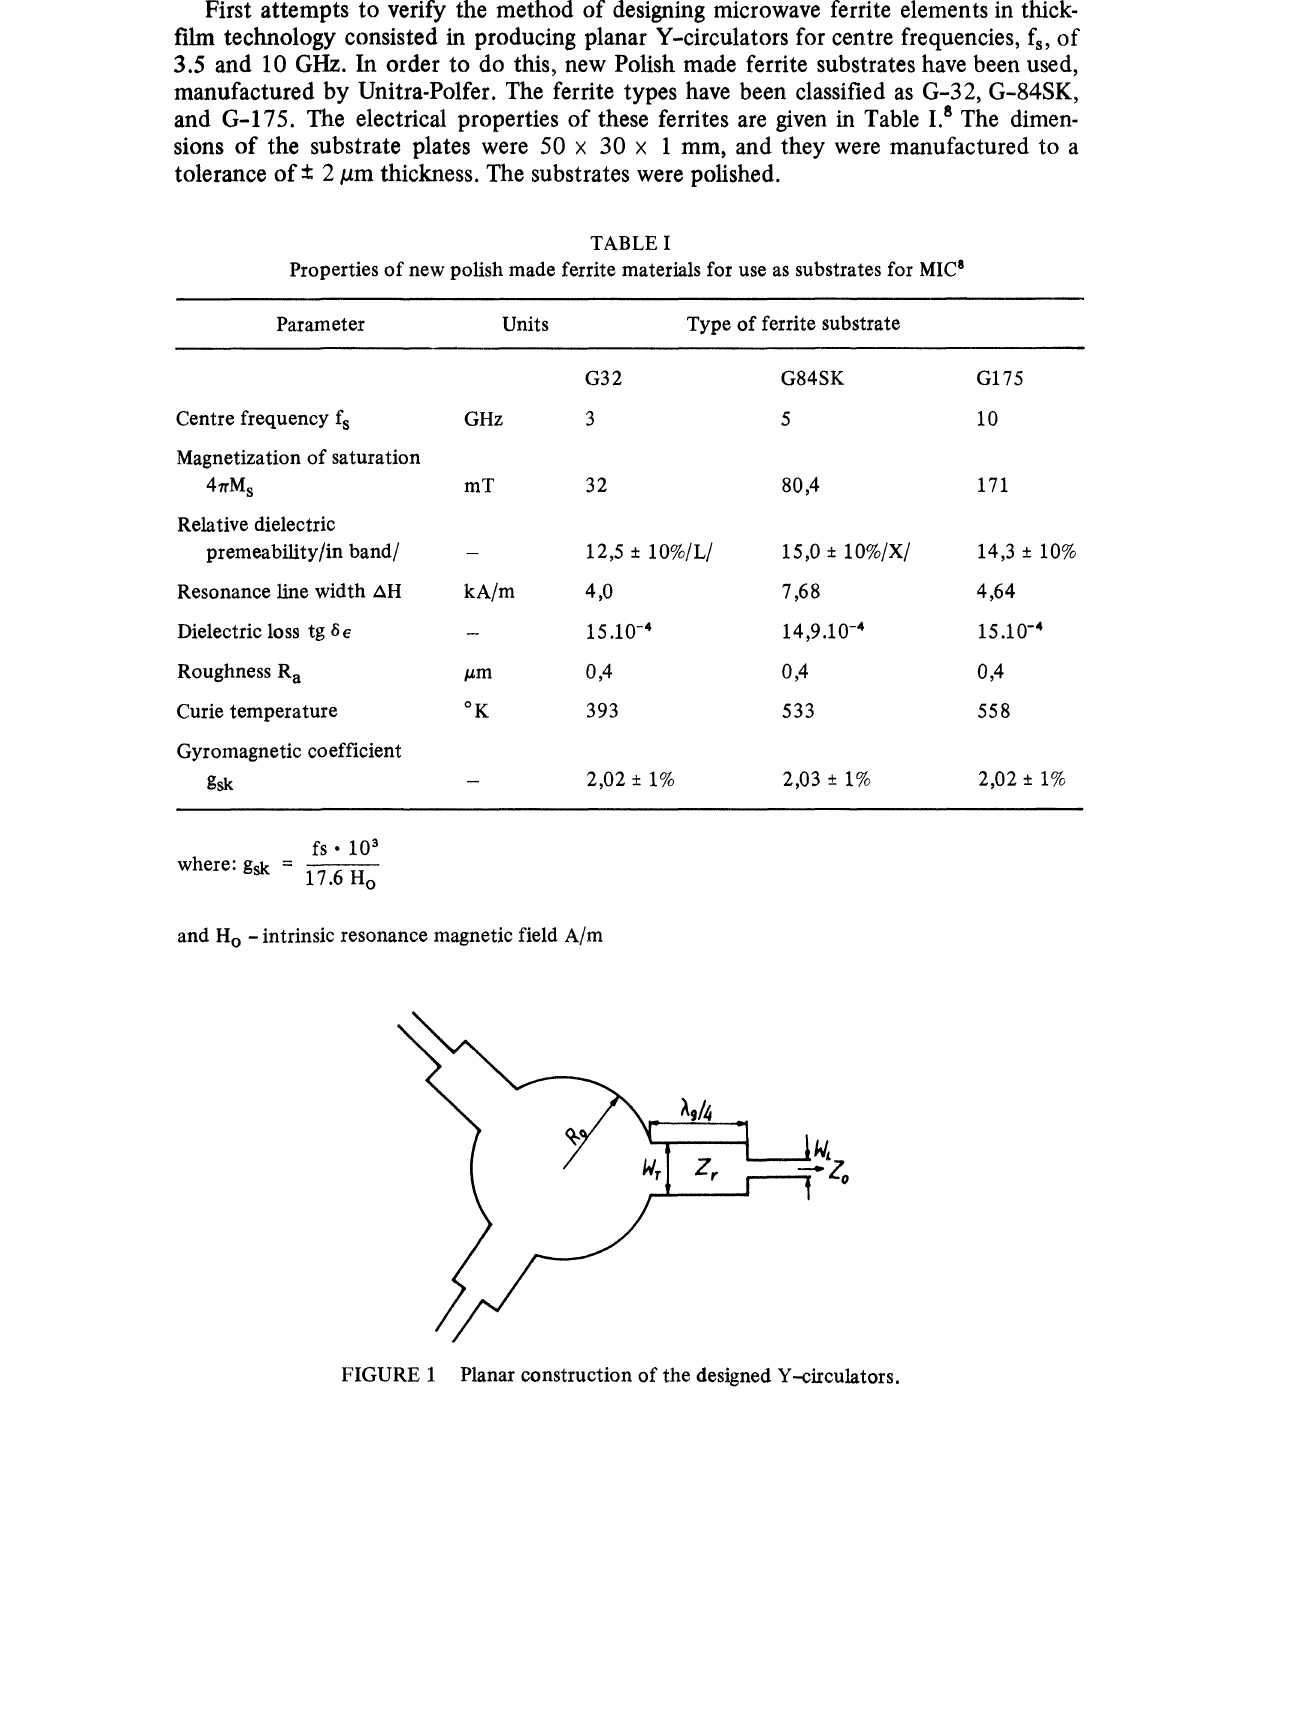
Properties of new polish made ferrite materials for use as substrates for MIC Parameter Units Type of ferrite substrate